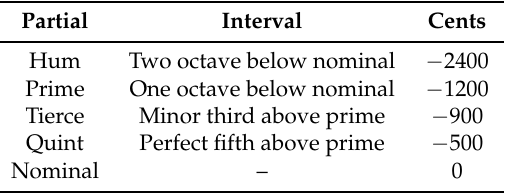
Table 3. Theoretical intervals for the lowest five partials.